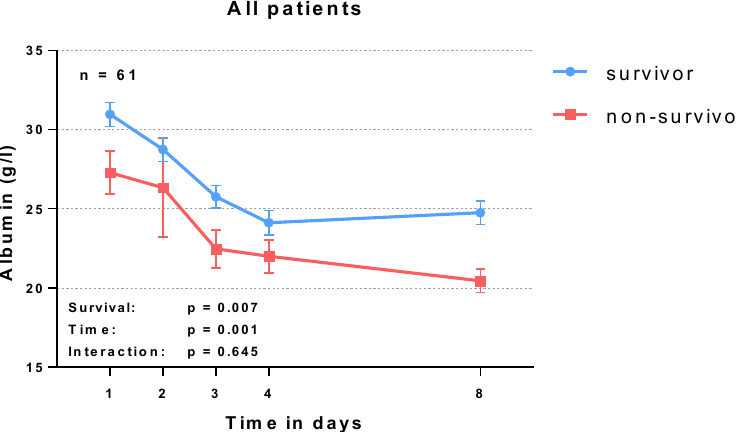
Figure 2. Mixed analysis of variance (ANOVA) for albumin dynamics during the fi rst 8 days of SC onset according to survivors and non-survivors at 30 days of follow-up.